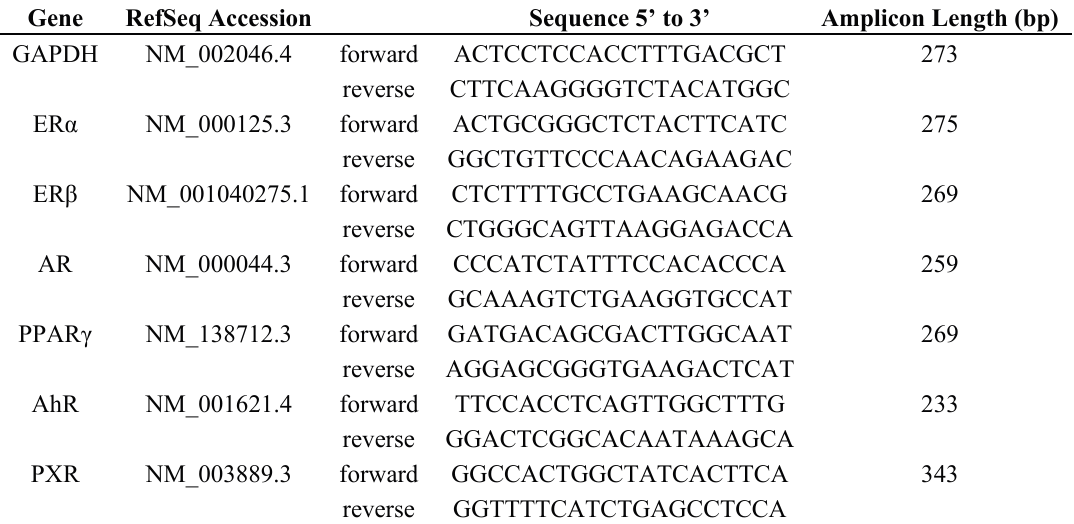
Table 1. Primers sequences, accession numbers and amplicon lengths for reference (GAPDH) and nuclear receptors (NR)